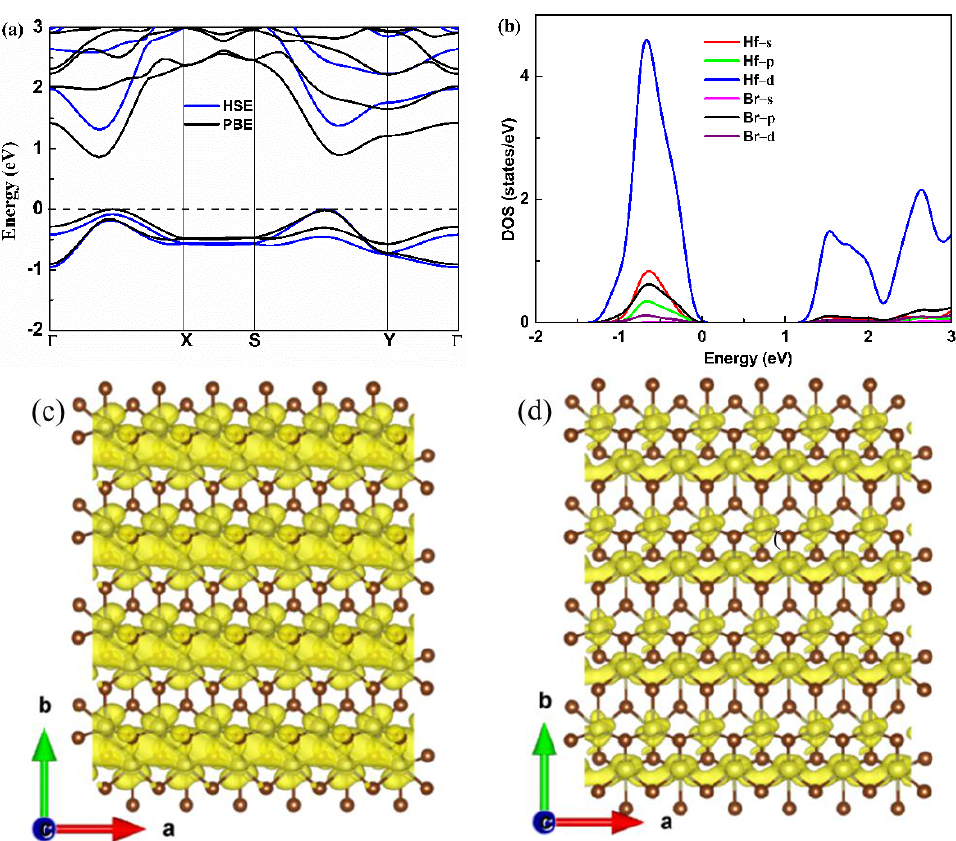
Figure 3. Electronic band structure ( a ), partial DOS ( b ), band decomposition charge density of VBM and CBM ( c , d ) for the monolayer Hf 2 Br 4 .